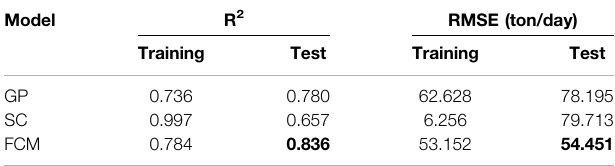
TABLE 1 | Performance of different models of the classical ANFIS.